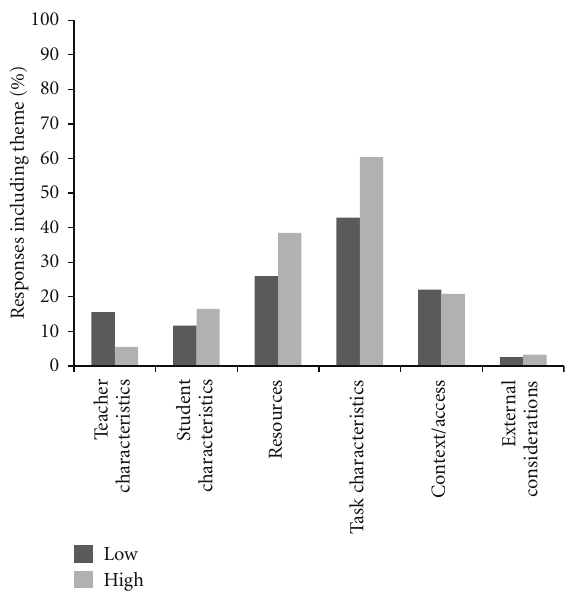
Figure 5: Patterns of themes by integration level for factors considered when planning to integrate computers in a